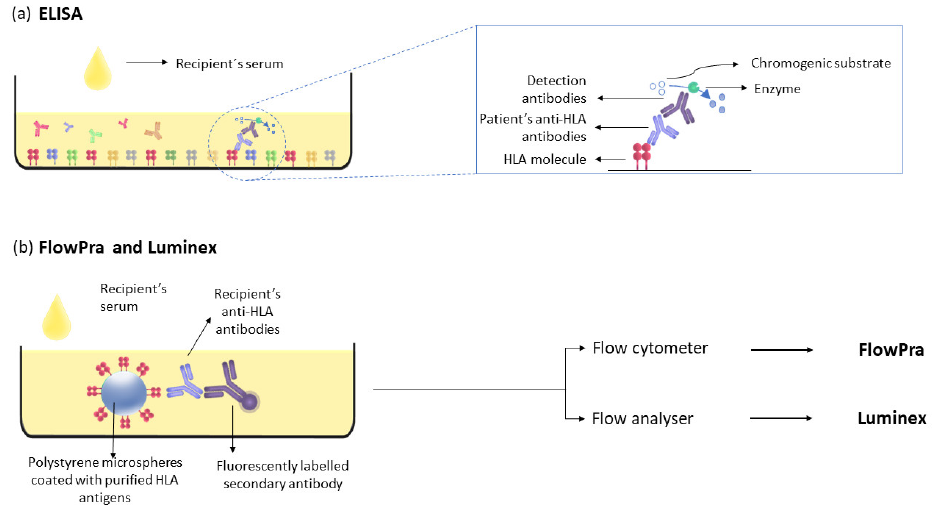
Figure 3. Solid-phase assays for detecting anti-HLA antibodies. ( a ) ELISA assay: HLA antigens are immobilised on the microtiter plate, and anti-HLA antibodies are detected after incubation with the recipient’s serum. ( b ) FlowPra and Luminex assays: anti-HLA antibodies from the recipient’s serum are detected by incubating the serum with polystyrene microspheres coated with HLA antigens and secondary antibodies.